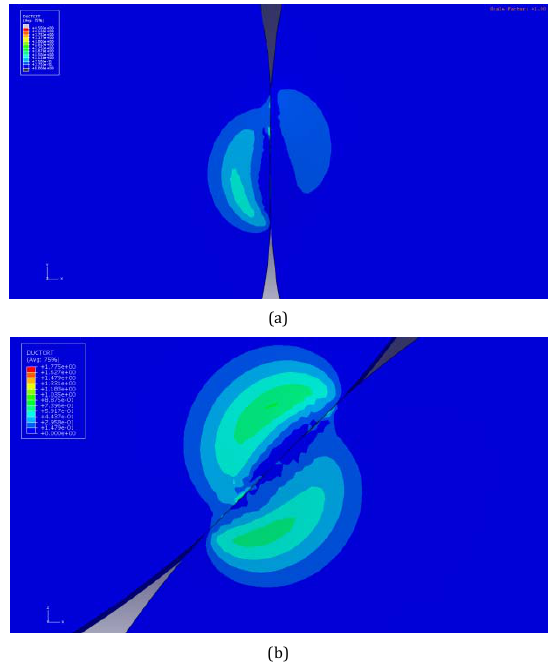
Figure 11. Damage contours at the contact points for (a) QS and (b) BCC models.